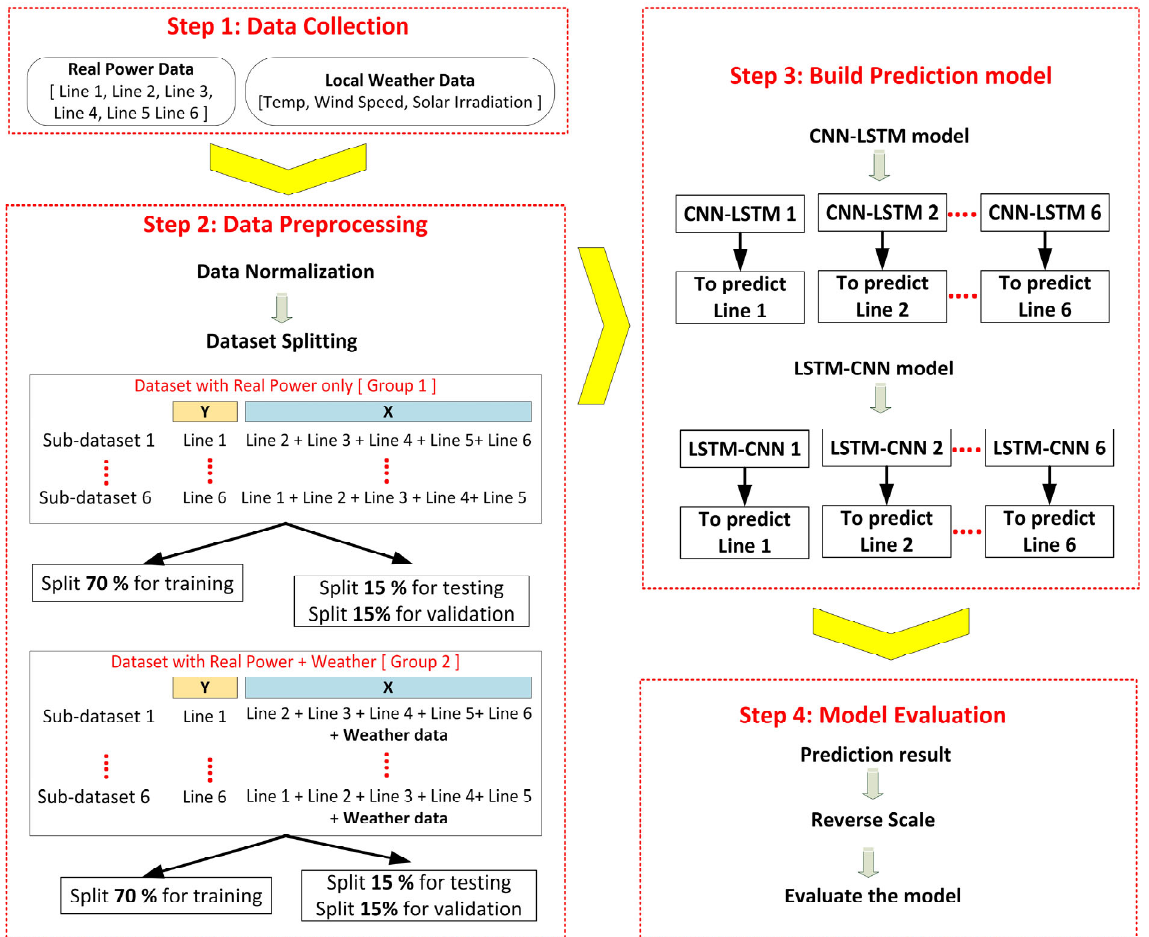
Figure 5. Proposed